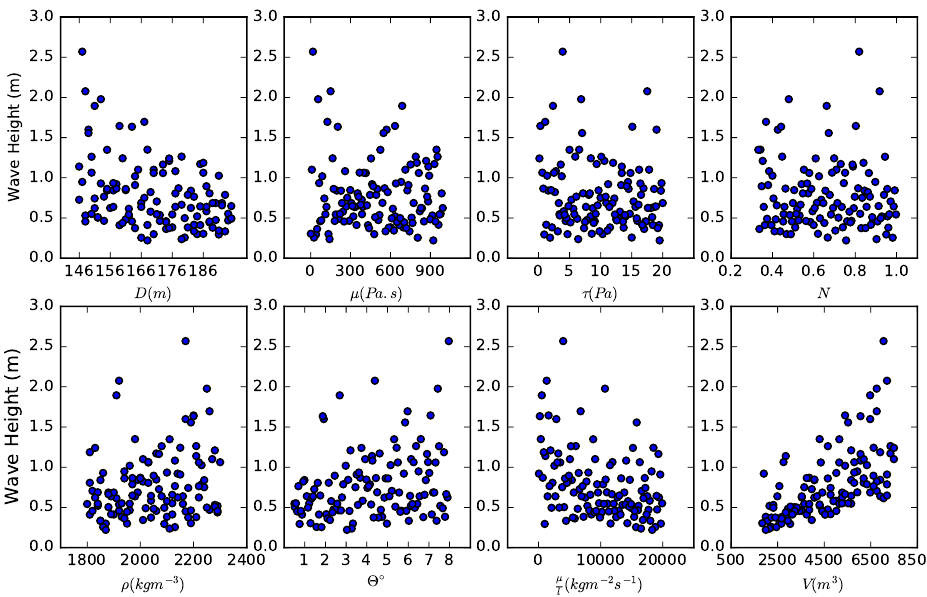
Figure 4. Scatter of simulated wave heights from all the truth model runs against each of the input parameters. Plots where the input parameter has a strong influence on the simulated wave height should show a trend, despite the variation in all the other input parameters across different truth